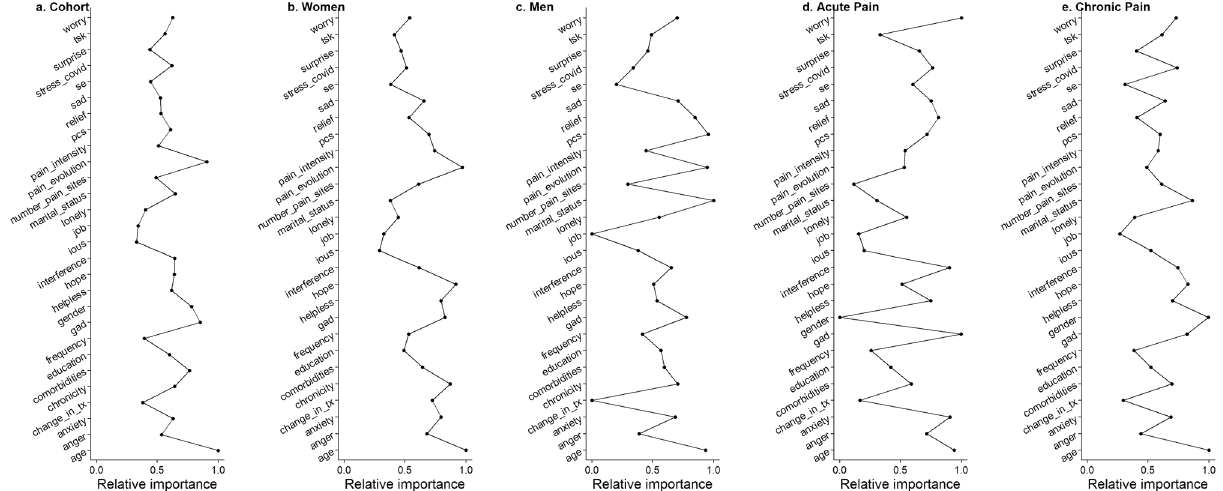
Figure 6. Centrality measures of Strength. Average correlations between centrality indices of networks sampled with persons dropped and networks built on the entire input dataset, at all follow-up time points.